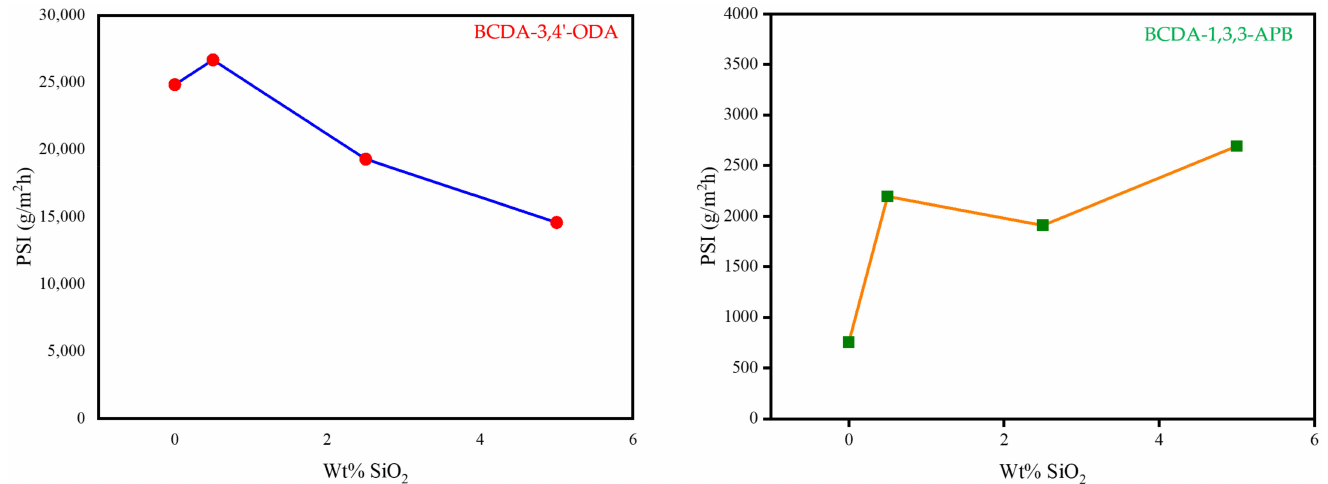
Figure 7. Variation in PSI (pervaporation separation index) with the increasing SiO 2 wt% in PI/SiO 2 mixed matrix membrane.